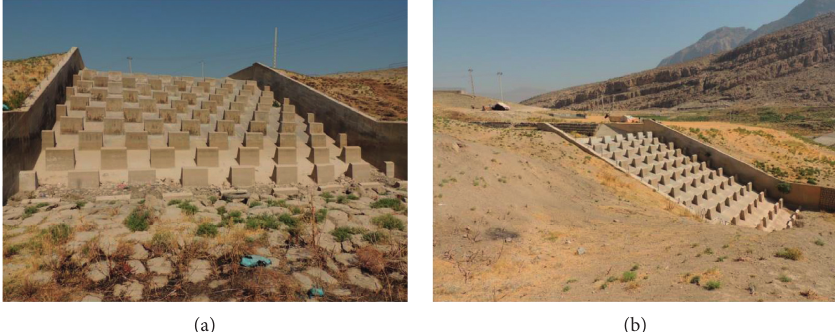
Figure 2: The main chute structure with baffle blocks of the irrigation and drainage network on the Doroodzan Dam, Fars province, Iran (the side outlet of Junaki inverted